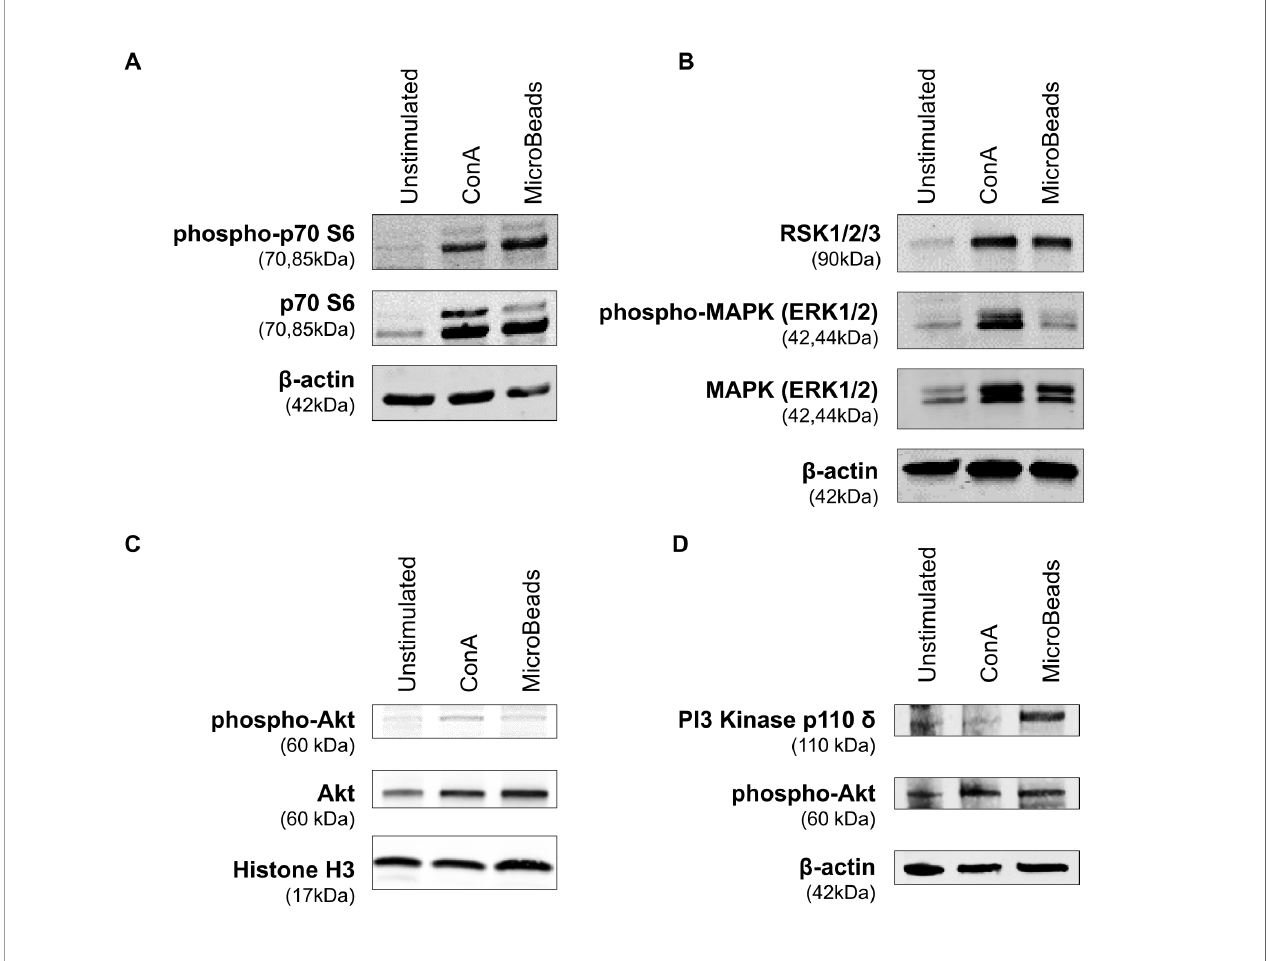
FIGURE 7 | Application of MicroBeads induce PI3K pathway. Western blot analysis of (A) phospho-p70 S6 Kinase, p70 S6 Kinase and b -actin (loading control) expression after 1h post stimulation with ConA or MicroBeads, (B) RSK1/2/3, phospho-MAPK (ERK1/2), MAPK (ERK1/2) and b -actin (loading control) expression after 1 h post stimulation with ConA or MicroBeads, (C) phospho-Akt, Akt and Histone-3 (loading control) expression after 1 h post stimulation with ConA or MicroBeads, (D) phospho-Akt, PI3 Kinase p110 d and b -actin (loading control) expression after 15 min post stimulation with ConA or MicroBeads. Results from one experiment with no replicates are